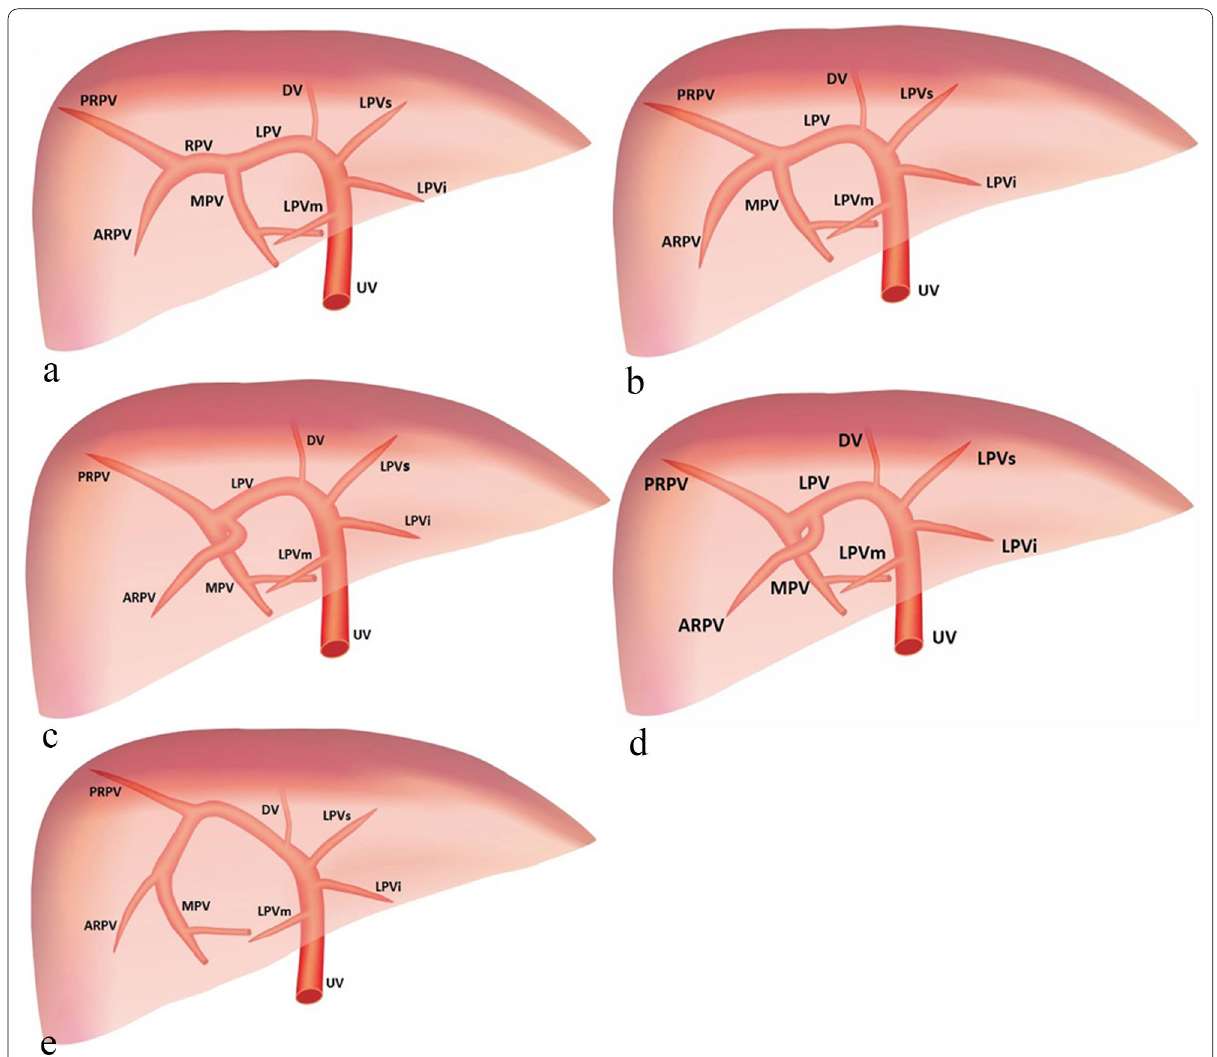
Fig. 6 Schemes illustrate the normal anatomy and anatomic variants in the connections of the intrahepatic portal veins. The normal course of the intrahepatic portal veins ( a ). Different types of portal vein variants: Type 1 ( b ), Type 2 ( c ), Type 3 ( d ) and Type 4 ( e